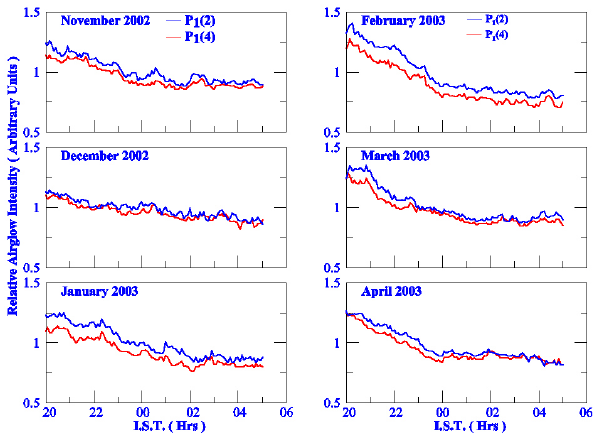
Fig. 4. Mean nocturnal variation of P 1 (2) and P 1 (4) intensity of OH(8,3) band for different months at Kolhapur during 2002–2003.